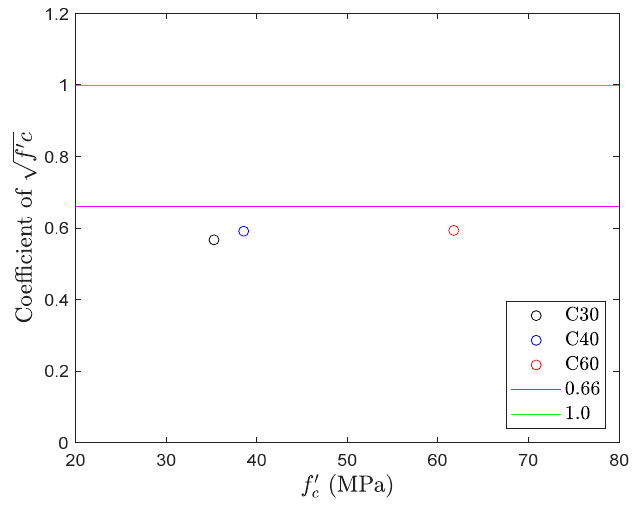
Figure 19. (cid:1858) (cid:3030) ′ coefficient of flexural test